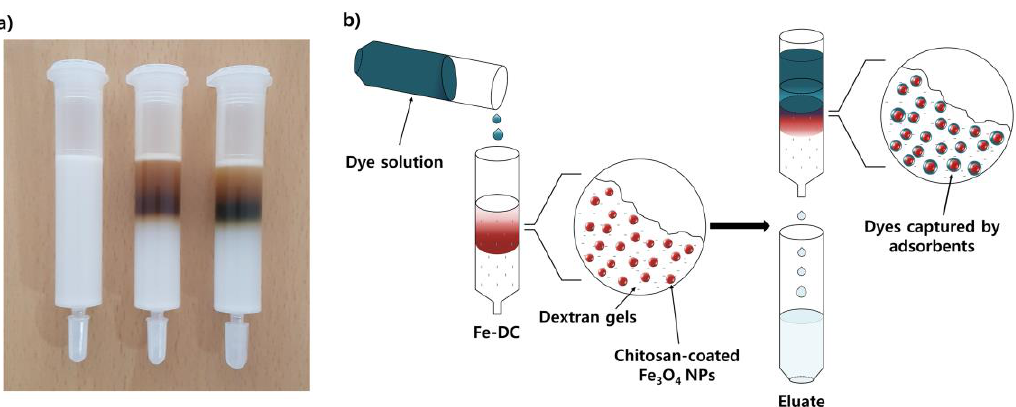
Figure 1. ( a ) Image of desalting columns: (left) bare PD-10, (middle) Fe-DC, and (right) Fe-DC after adsorption of EB; ( b ) schematic illustration of the dye adsorption process from aqueous solutions using Fe-DC under continuous flow conditions (~1.5 mL / min).